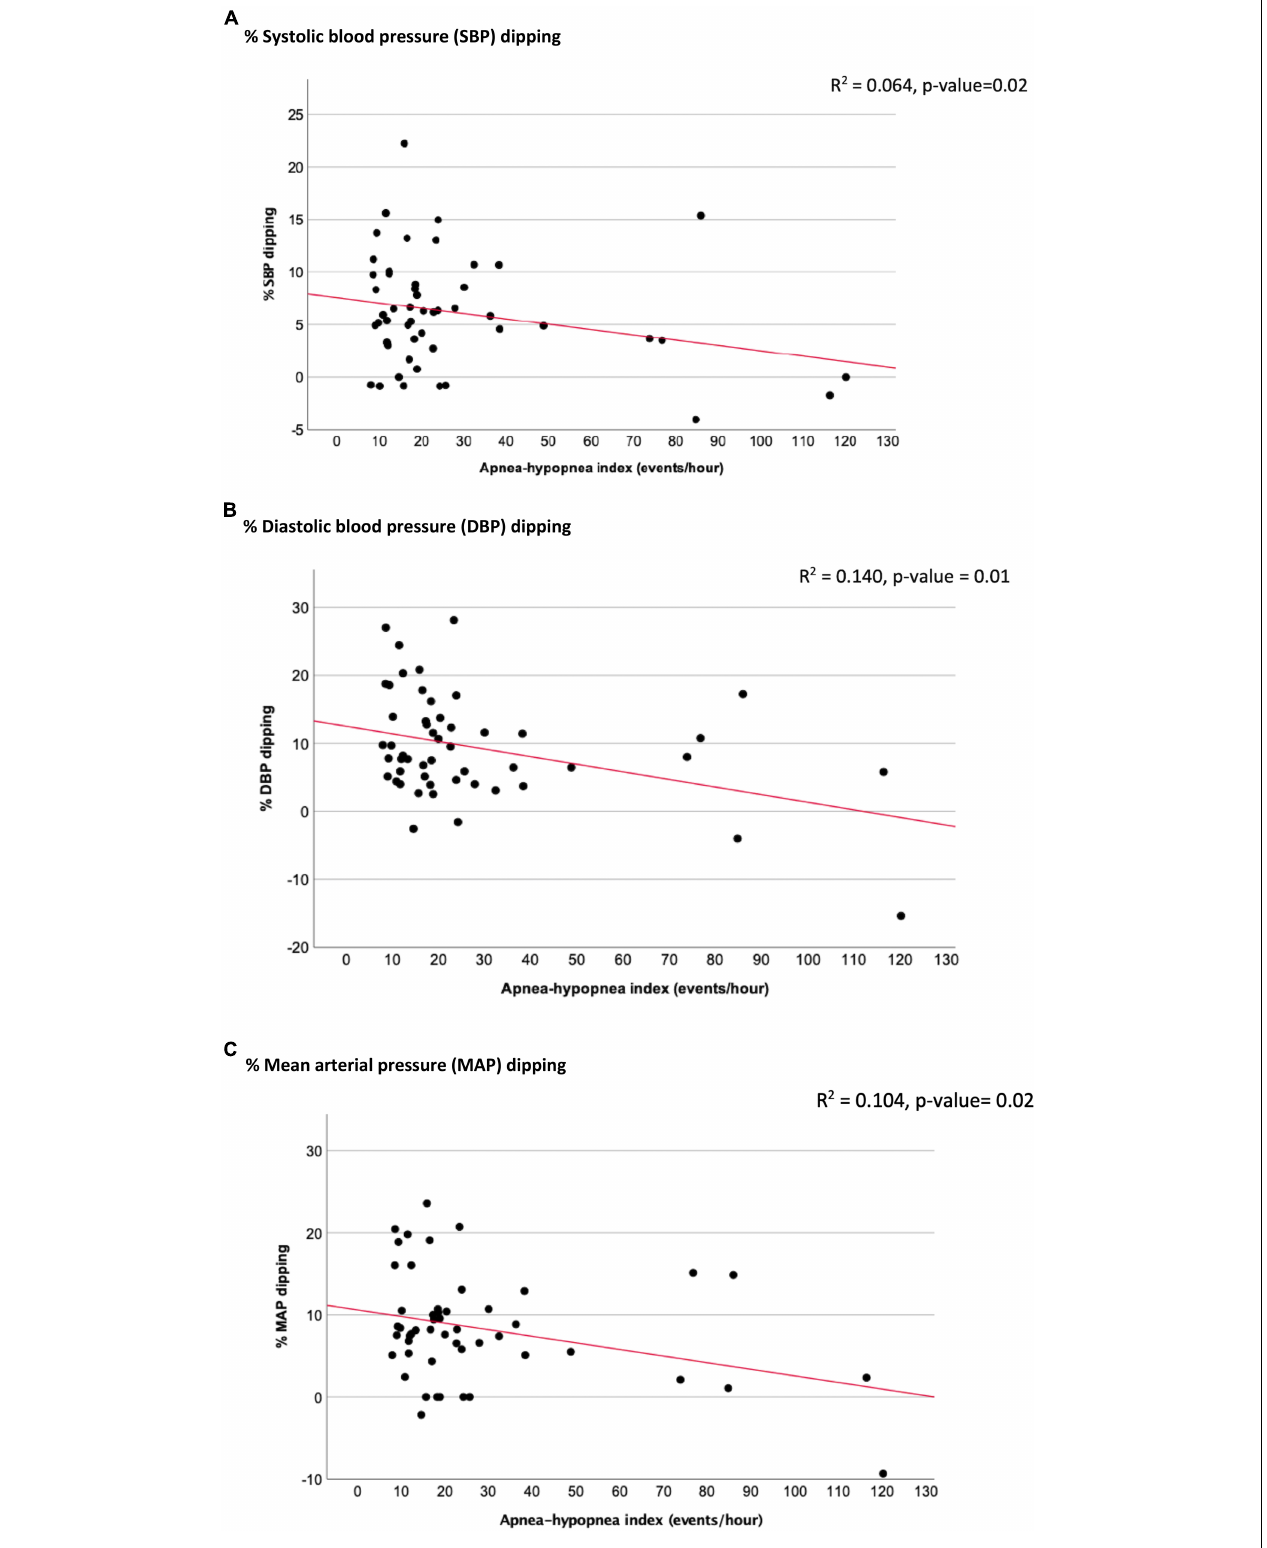
FIGURE 2 | Linear regression models demonstrated association between % blood pressure dipping and apnea-hypopnea index. (A) % Systolic blood pressure (SBP) dipping. (B) % Diastolic blood pressure (DBP) dipping. (C) % Mean arterial pressure (MAP) dipping.